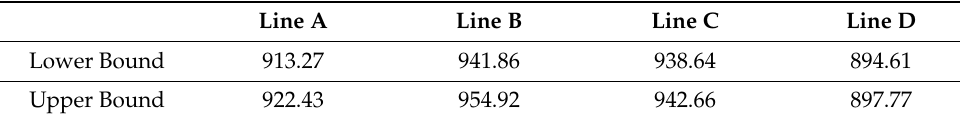
Table 5. Confidence interval for the mean per line, without